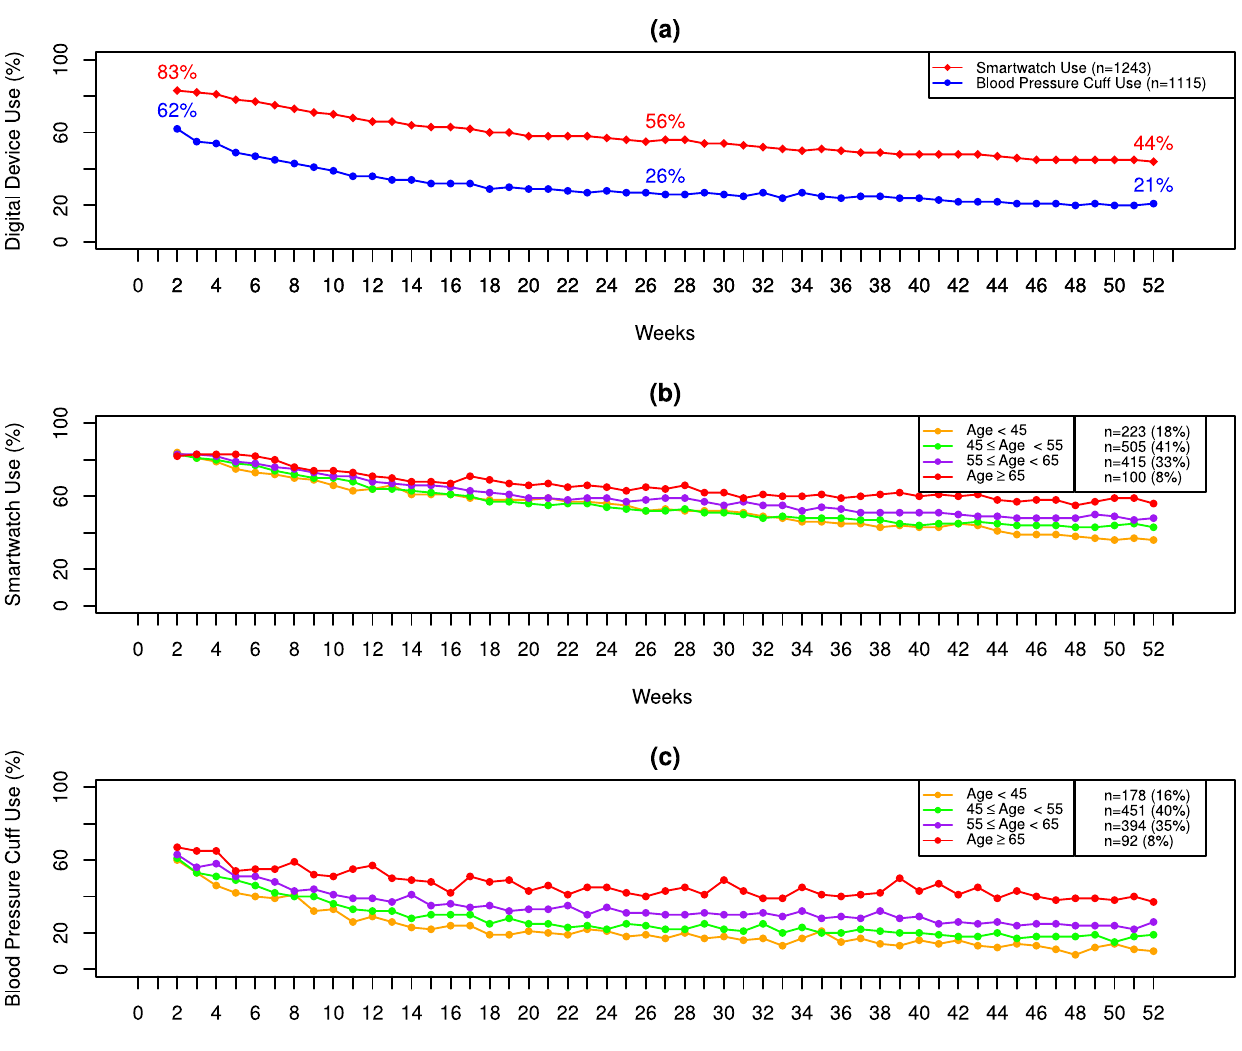
Fig. 3 Trends of Smartwatch and Digital BP Cuff Use over 52 weeks. a Digital device use over 52 weeks. b Smartwatch Use Strati fi ed by Age. c Digital Blood Pressure Cuff Use strati fi ed by